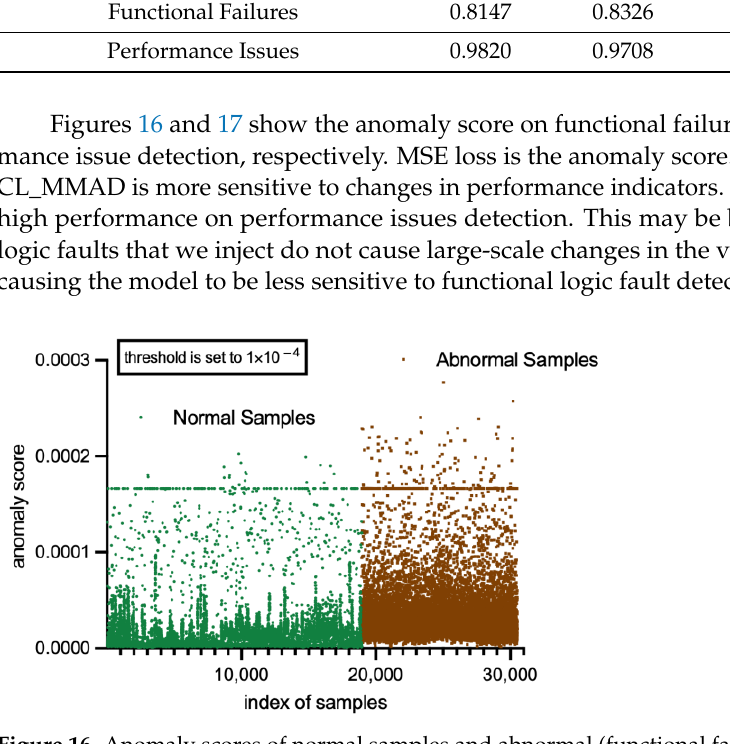
Figure 16. Anomaly scores of normal samples and abnormal (functional failures) samples produced by CL-MMAD using MSE loss.